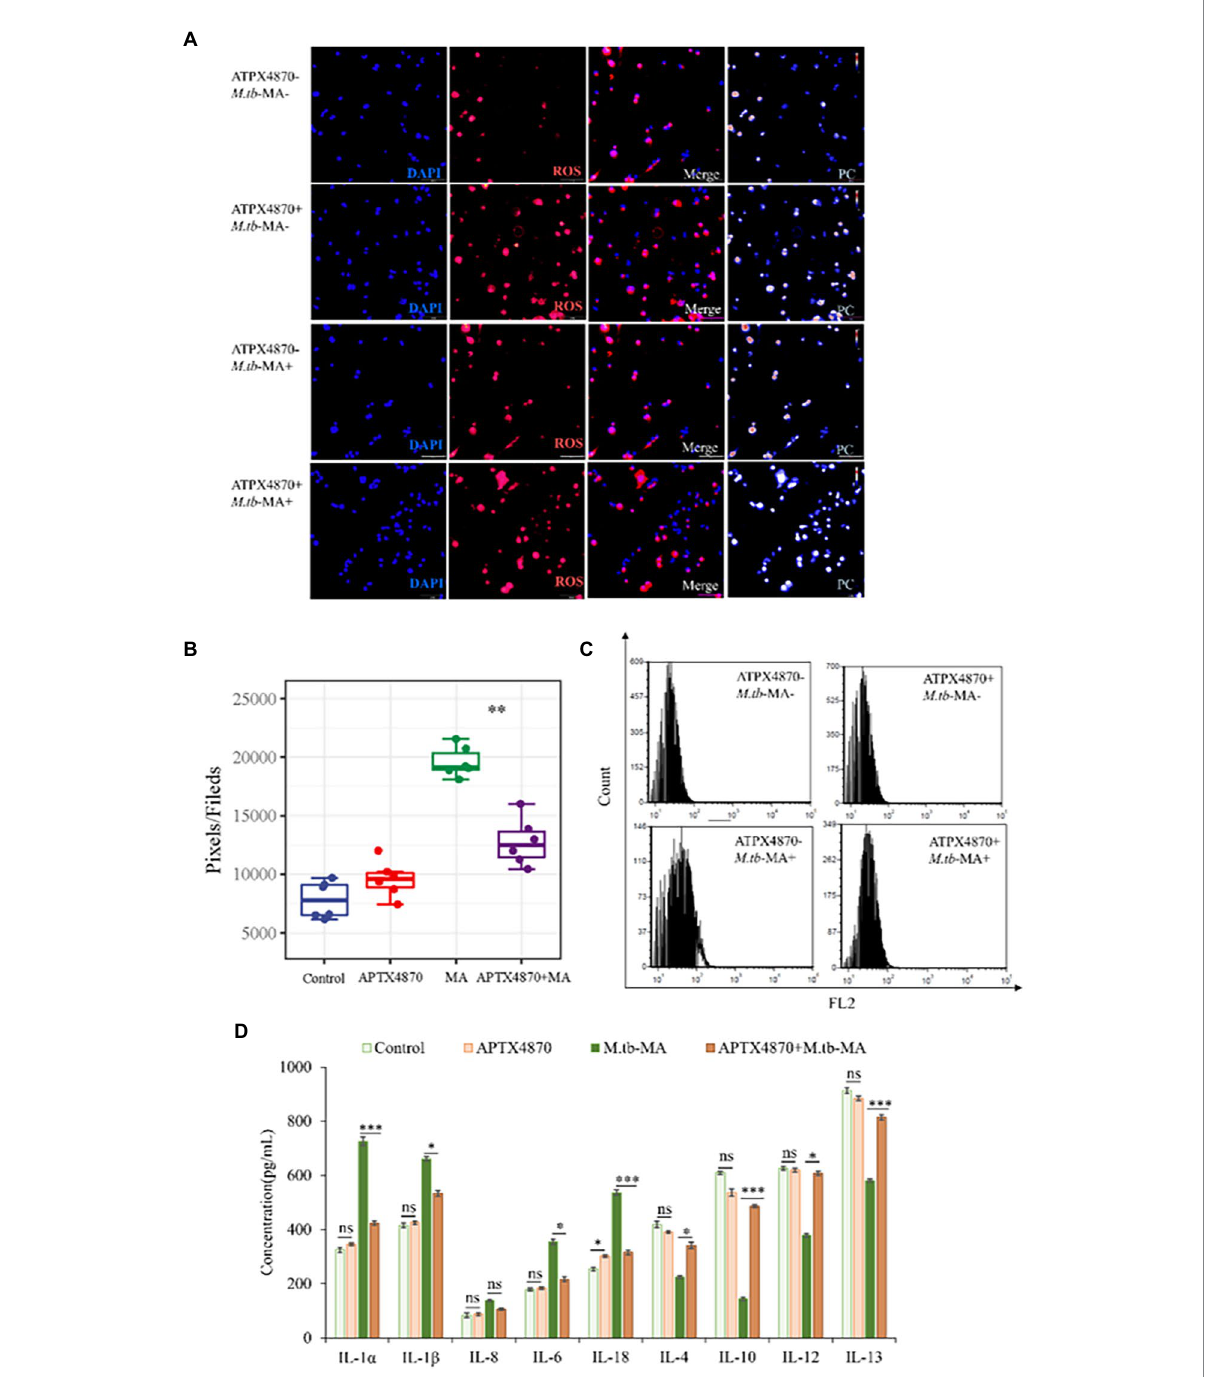
FIGURE 6 ROS-dependent cell apoptosis induced by M.tb -MA infection could be inhibited by APTX4870 in vitro . (A,B) The expression of ROS was analyzed by immunofluorescence cytochemistry. ROS is visualized in red and DAPI-stained nuclei in blue. Pseudo-color is used to show the difference in fluorescence intensity. Scale bars: 50 μ m. Results from one experiment, representative of 6 independent experiments ( n = 6), are shown. Quantitative the expression of ROS by optical densitometry assay using ImageJ Software version 1.46. Data were presented as mean ± SD, * p < 0.05; ** 0.01 < p < 0.05; *** p < 0.001: APTX4870+ M.tb -MA vs. M.tb -MA. (C) Flowcytometric analysis of total ROS accumulation ( n = 3). (D) The concentration of pro-inflammatory factors and anti-inflammatory factors was measured through ELISA ( n = 3). Data were presented as mean ± SD, compared with uninfected controls, * p < 0.05; ** 0.01 < p < 0.05; *** p < 0.001: APTX4870+ M.tb -MA vs. M.tb